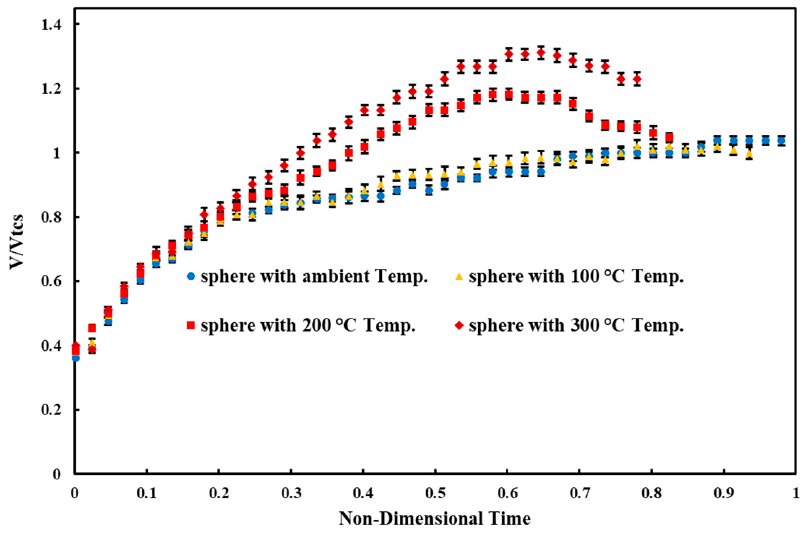
Figure 8. Dimensionless velocity versus dimensionless time for the sphere at different temperatures near the wall.